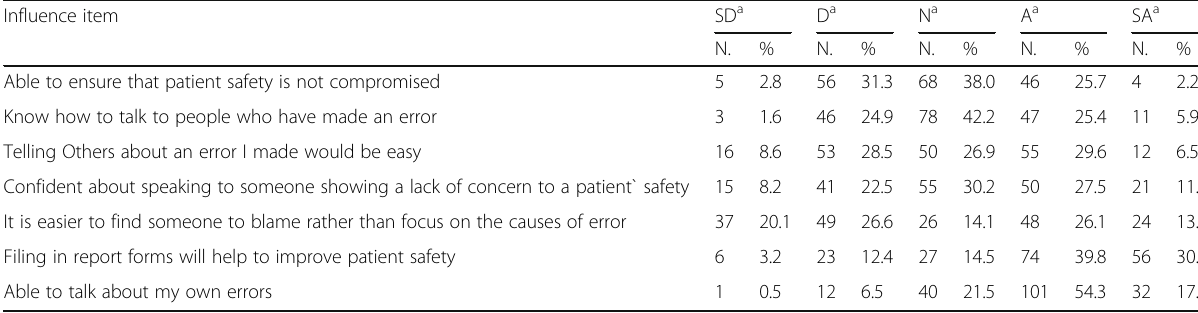
Table 3 Personal influence over safety among participated physicians Influence item